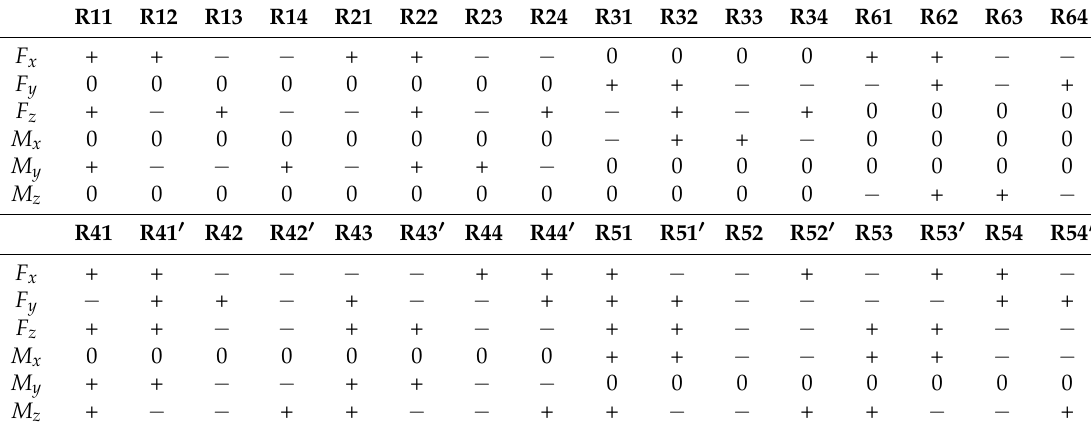
Table 3. Plus or minus of strain under forces or torques